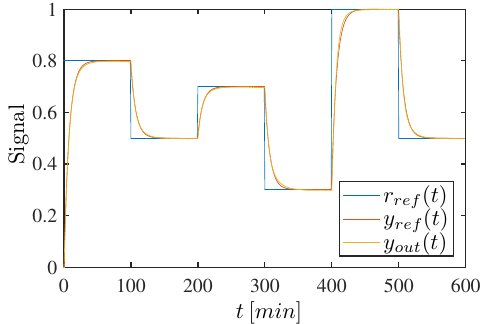
Figure 28. Optimization results with training data.